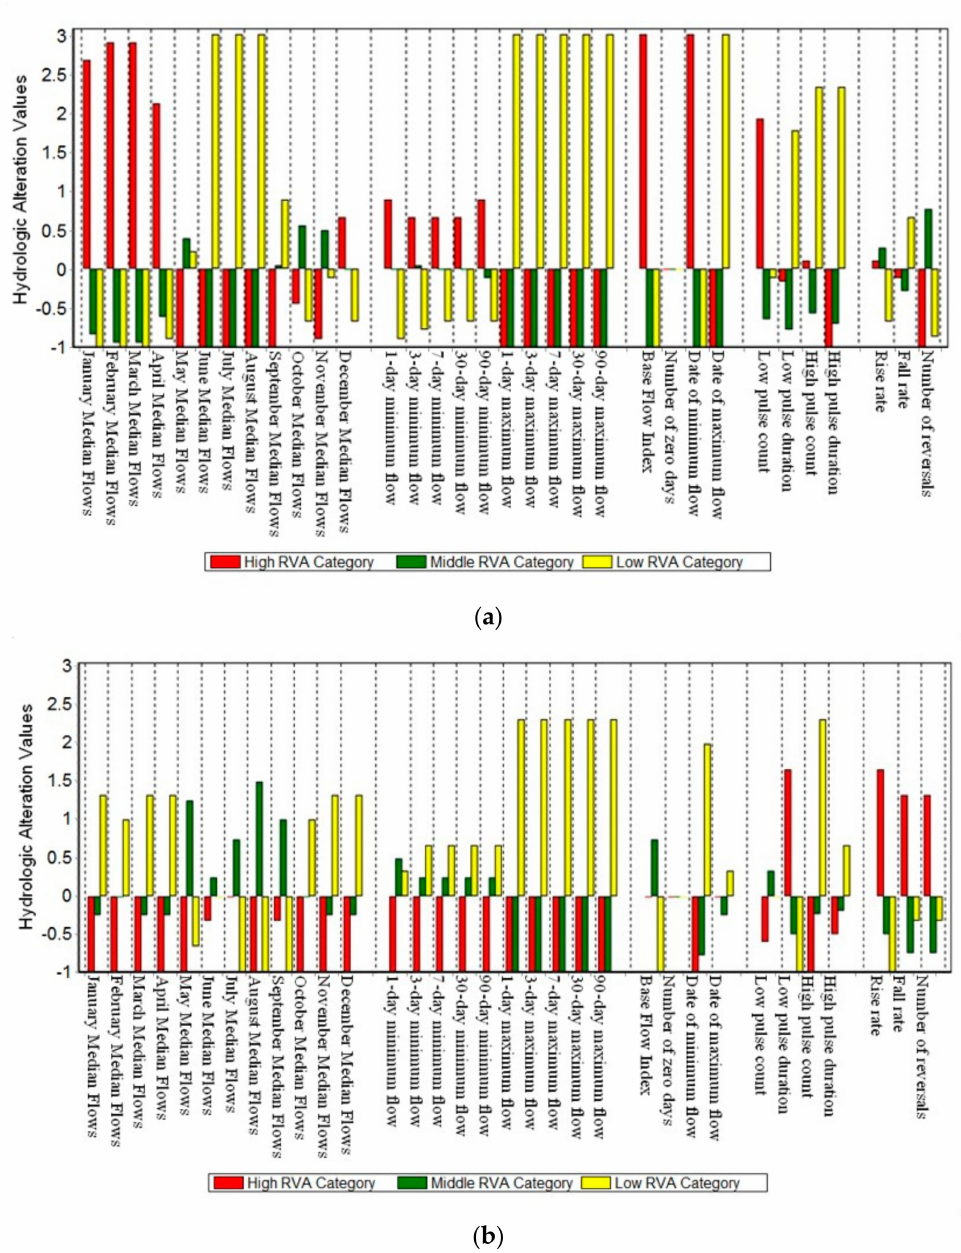
Figure 7. Comparison of hydrologic alteration under different scenarios. ( a ) Current hydrologic alteration. ( b ) Hydrologic alteration under the sustainable boundary with optimized